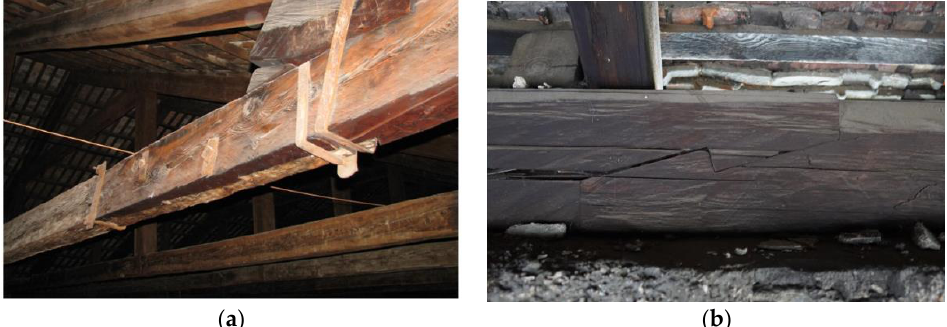
Figure 4. Examples of scarf and splice joining of wooden beams in existing buildings: ( a ) building in Italy, ( b ) building in Poland — 13th century Czocha Castle in Sucha.